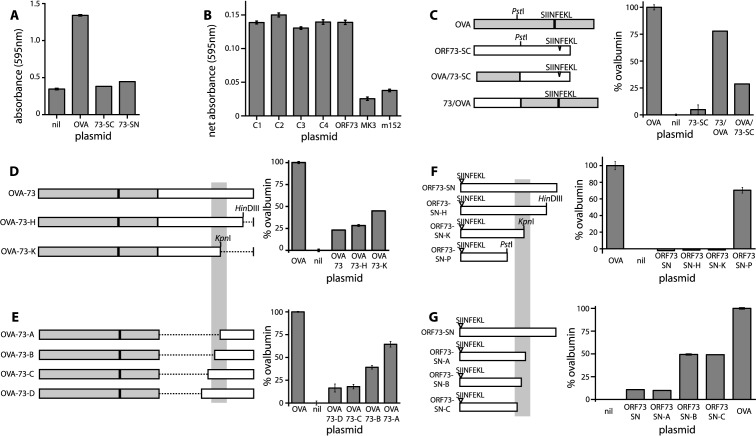
Inhibition of MHC Class I–Restricted Epitope Presentation by Physical Linkage to ORF73(A) The SIINFEKL epitope of OVA was introduced into ORF73 near either its N-terminus (ORF73-NC) or its C-terminus (ORF73-SC). Both ORF73 derivatives were cloned into the pcDNA3 expression vector and compared with OVA in the same vector for their capacity to stimulate the SIINFEKL-specific T cell hybridoma B3Z after transfection into L929-Kb cells. After 48 h, beta-galactosidase production was assayed by cell lysis in the presence of chlorophenol-red-beta-D-galactoside and reading absorbance at 595 nm. nil, vector only.(B) L929-Kb cells were co-transfected with OVA plus the plasmid indicated. C1–C4 are control plasmids, expressing MHV-68 ORFs 19, 30, 31, and 35, respectively. K3 degrades MHC class I heavy chains and m152 is a murine cytomegalovirus gene that retains MHC class I molecules in the endoplasmic reticulum. Net absorbance = A595 with co-transfection − A595 with untransfected cells (<0.02).(C) Hybrids of OVA and ORF73-SC were made to identify regions of ORF73 that inhibited SIINFEKL presentation. Responses are expressed as 100(A595 with plasmid − A595 with untransfected)/(A595 with OVA transfection − A595 with untransfected). nil, vector only. Mean ± standard deviation (SD) values of triplicate cultures are shown. Each graph is representative of at least three separate experiments. In at least one experiment, equal transfection efficiency was confirmed by co-transfecting a GFP expression plasmid and checking fluorescence under ultraviolet illumination.(D) ORF73 was fused to the C-terminus of the OVA coding sequence in pcDNA3. C-terminal deletions were then made as shown. Each construct was transfected into L929-H2-Kb cells. The shaded area in (D–G) highlights a region of ORF73 that appeared to be important for inhibiting epitope presentation.(E) N-terminal ORF73 truncations were generated by PCR and fused in frame to amino acid 325 of OVA. Each construct was transfected into L929-H2-Kb cells and assayed for SIINFEKL presentation as in (D).(F) Progressive truncations of ORF73-SN were assayed for their capacity to present the SIINFEKL epitope to B3Z cells after transfection into L929-Kb cells. Selective presentation from the ORF73-SN-PstI construct was confirmed in multiple experiments, including independent plasmid preparations.(G) PCR-generated C-terminal truncations of ORF73-SN were assayed for SIINFEKL presentation after transfection of L929-H2-Kb cells. Deletions across the area identified as important for inhibiting epitope presentation in (D–E) again improved epitope presentation.